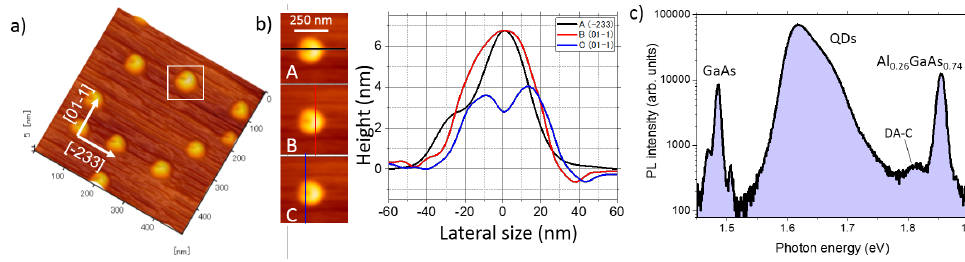
Figure 1. ( a ) Atomic force microscope micrograph representing a 3D view of uncapped GaAs quantam dots (QDs) grown on a (311)A oriented Al 0.26 Ga 0.74 As surface. The main crystallographic axes are highlighted. ( b ) Left panels: blow-up of a single QD from panel ( a ). A, B, and C highlight cuts in different crystallographic directions and points of the QD and are reported in the right panel. ( c ) Photoluminescence (PL) spectrum (in semi-log scale) at 5 K showing the emission of (respectively, from the low to the high energy side) the GaAs, the GaAs QDs, the carbon donor–acceptor (DA-C), and the Al 0.26 Ga 0.74 As barrier